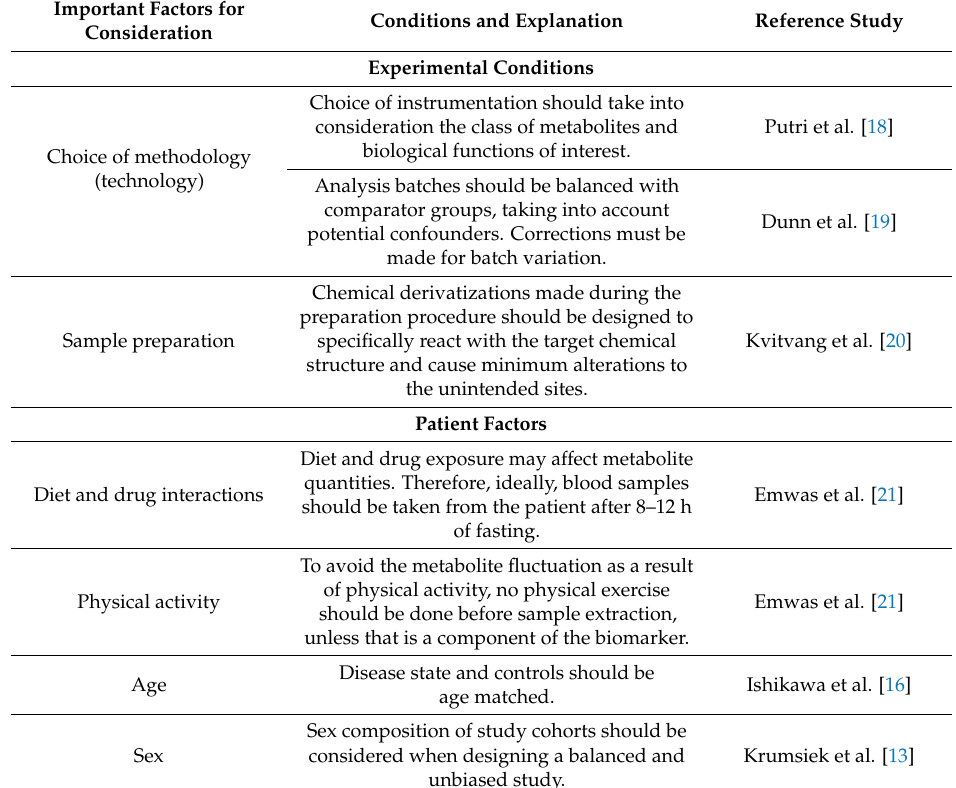
Table 1. Potential confounding factors that must be considered in the development of a reproducible metabolomic biomarker, in the discovery and validation